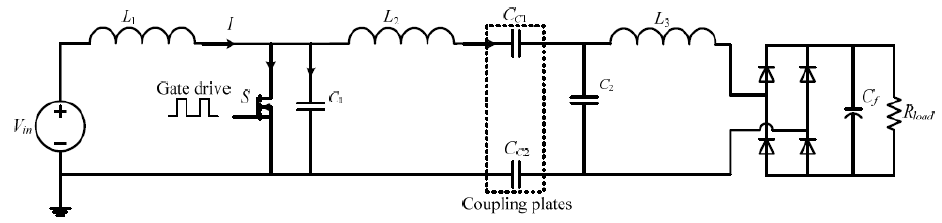
Figure 10. A CCWPT system based on a Class E inverter with LCL